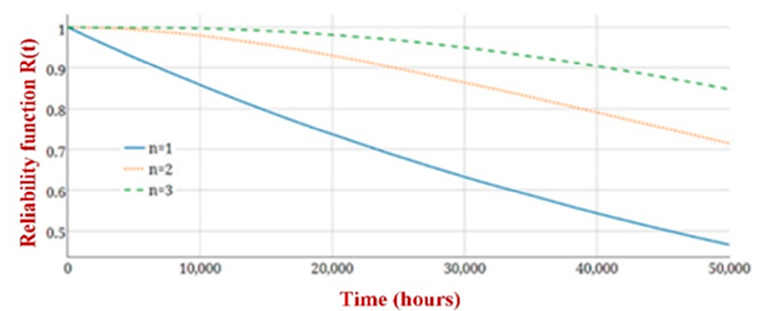
Figure 24. The influence of redundant series on CHB dependability. Figure 24. The in fl uence of redundant series on CHB dependability.